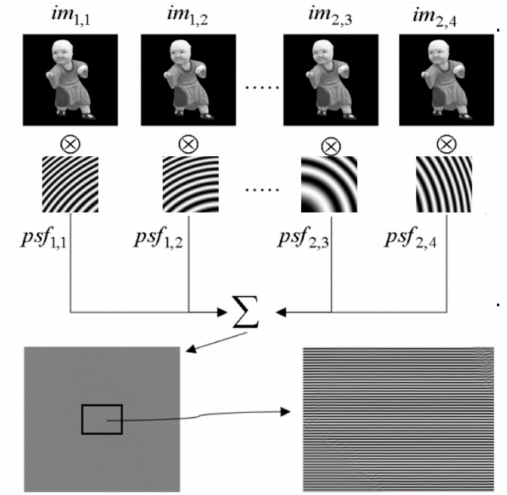
Figure 5. The process of hologram calculation through convolution of corresponding PSF with projected images.